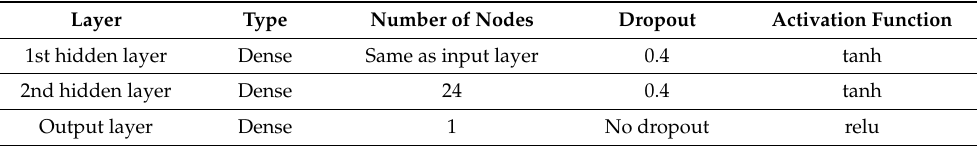
Table 2. Neural network architecture and hyper-parameters.